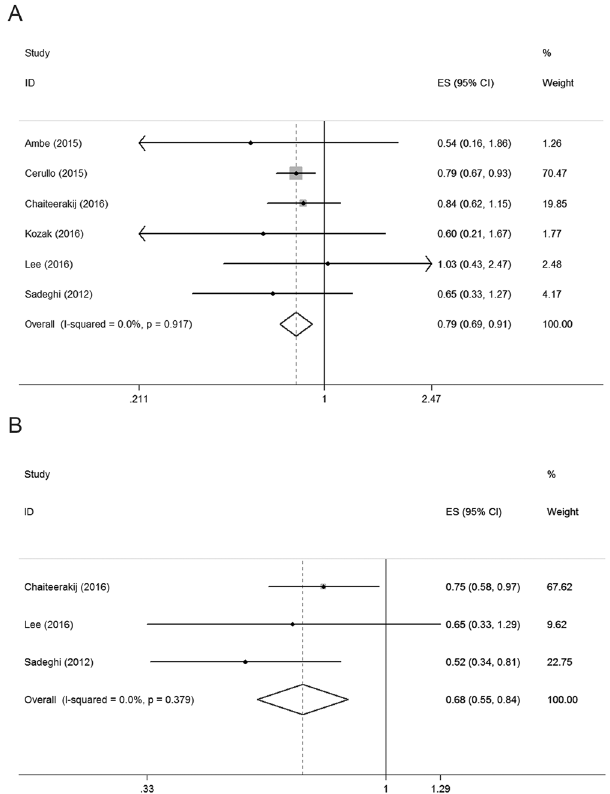
Figure 3. Forest plot for survival in patients at resectable stage ( A ) and locally advanced stage ( B ).